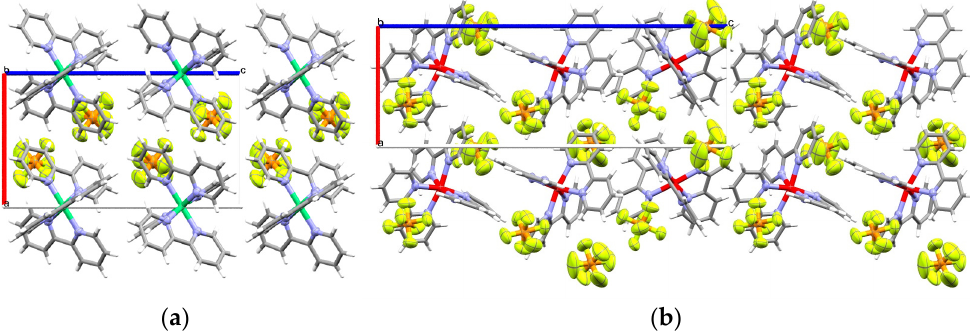
Figure 1. Diagrams of ( a ) [ rac -Ni(bpy) 3 ](PF 6 ) 2 and ( b ) [ Λ -Zn(bpy) 3 ](PF 6 ) 2 from X-ray diffraction. C gray; H white; N lavender; Ni green; Zn red. Ellipsoids of non-C non-H shown at 50% probability